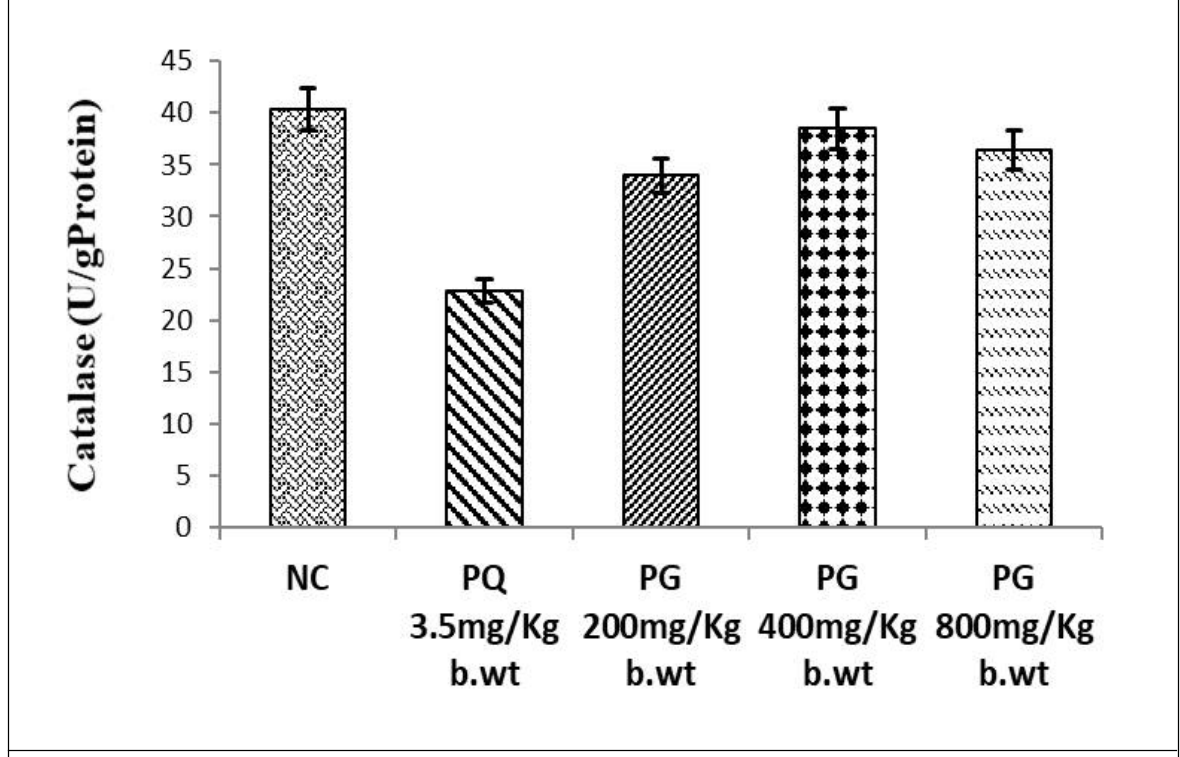
Figure 8: Effect of Psidium guajava leaf extract administration on serum catalase activity of male Wistar albino rats administered 3.5 mg/kg b.wt. Paraquat